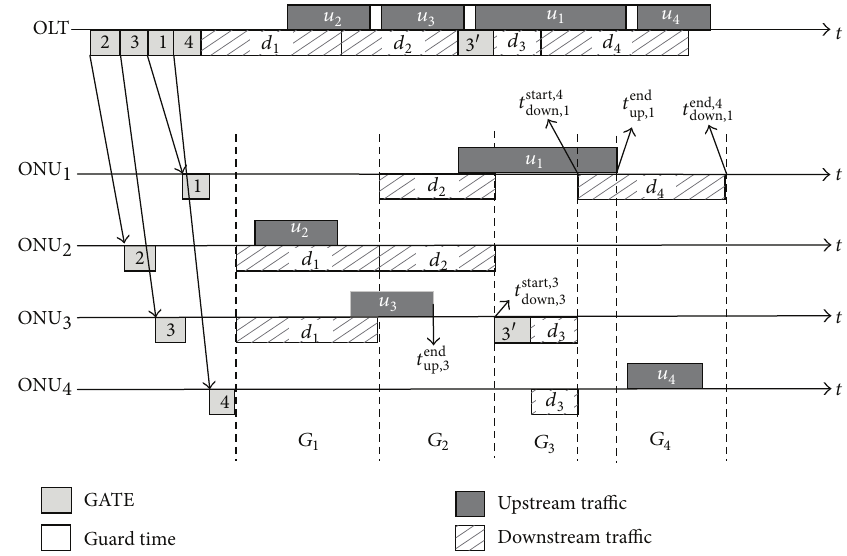
Figure 4: Sequence chart of EPON traffic